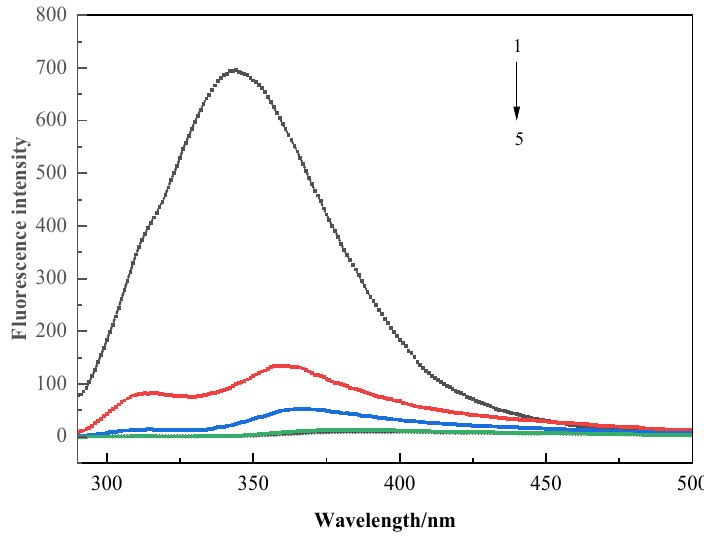
Figure 5. E ff ect of apple polyphenol addition on the fl uorescence spectra of processed cheese. Labels Figure 5. Effect of apple polyphenol addition on the fluorescence spectra of processed cheese. Labels 1 to 5 indicate apple polyphenol content of 0% to 1.6%. 1 to 5 indicate apple polyphenol content of 0% to